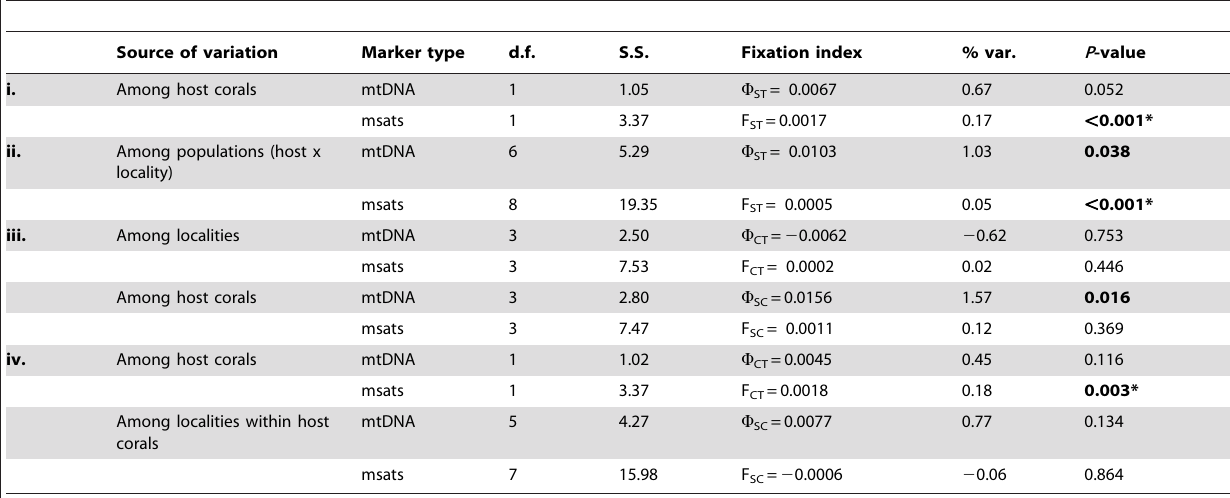
Table 4. AMOVA results for tests of host-associated differentiation among populations of Coralliophila abbreviata using mtDNA and microsatellite (msats) data.